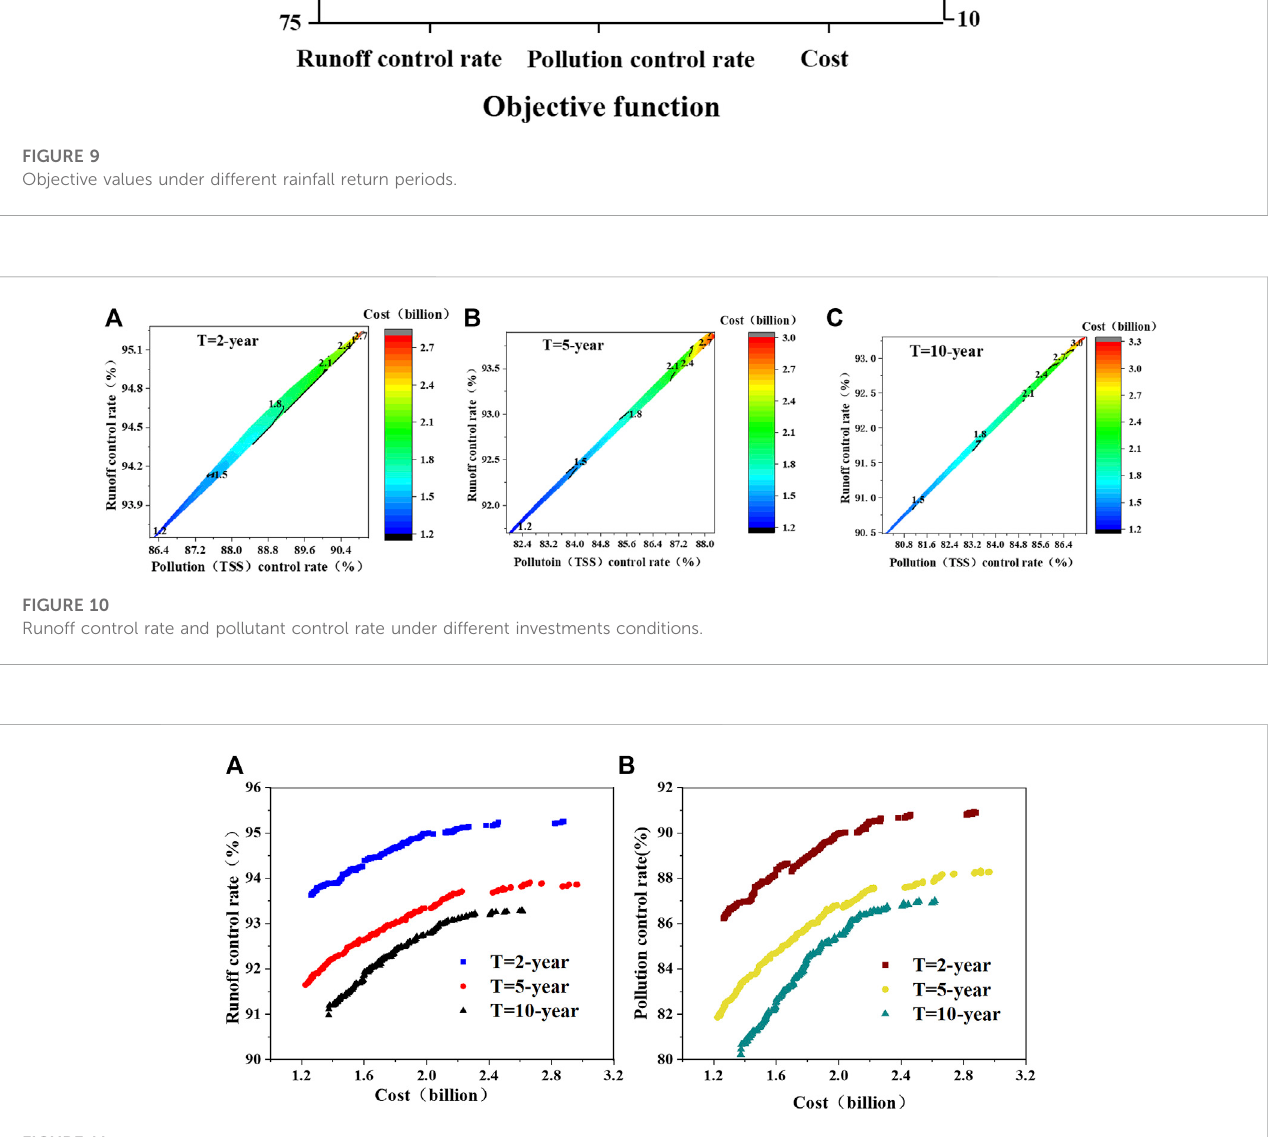
FIGURE 11 Water quantity-cost trade-off and water quality-cost trade-off curves under different return